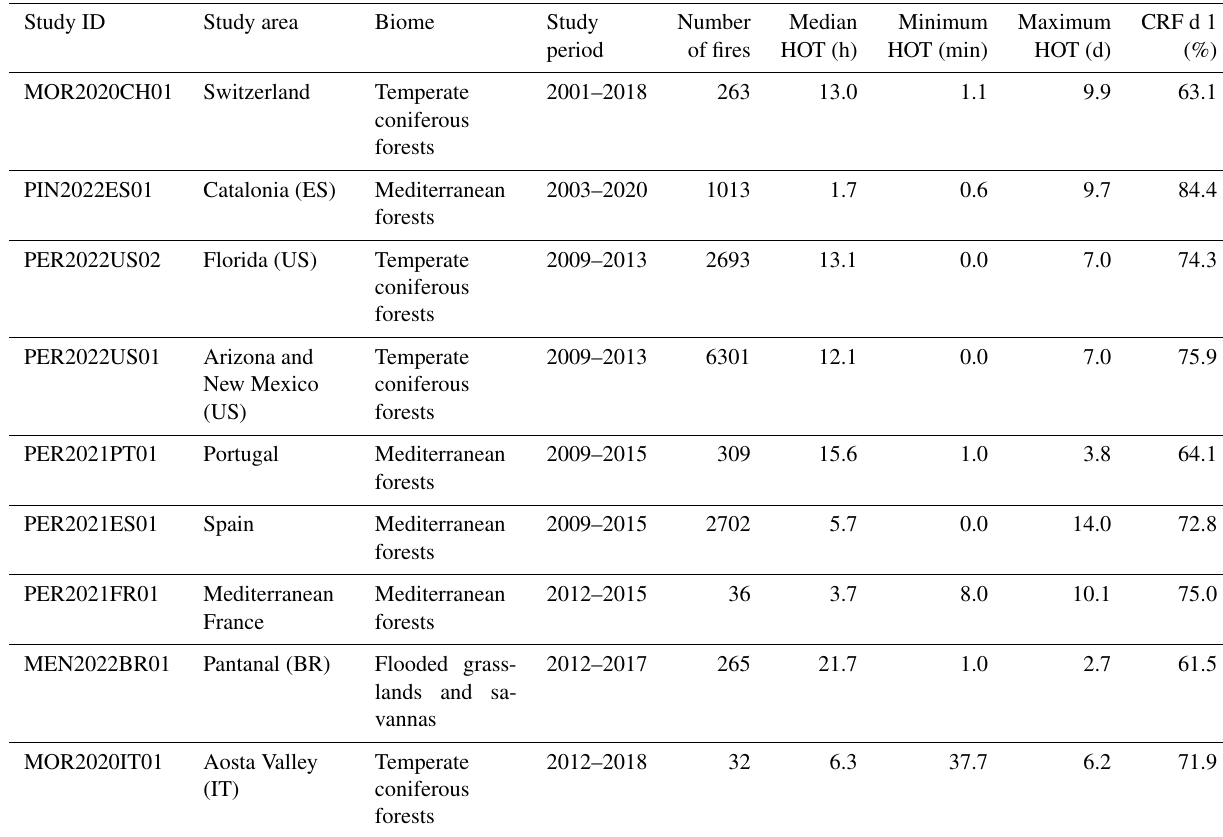
Table 4. Summary of the non-censored data from the database on holdover time of LIWs. Study ID Study area Biome Study Number Median Minimum Maximum CRF d 1 period of fires HOT (h) HOT (min) HOT (d) (%)